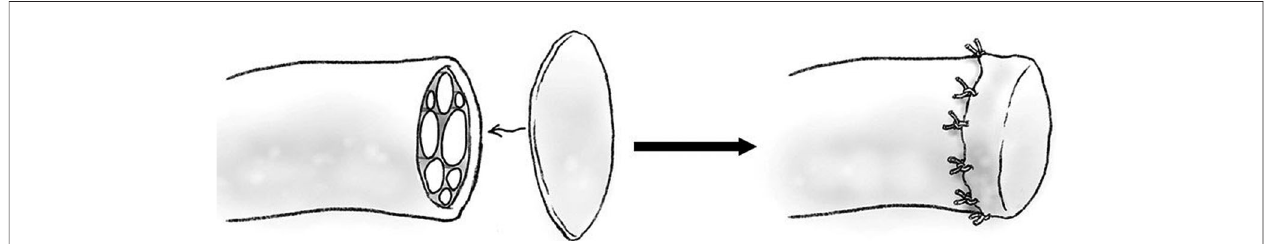
FIGURE 1 | Diagram of epineurial